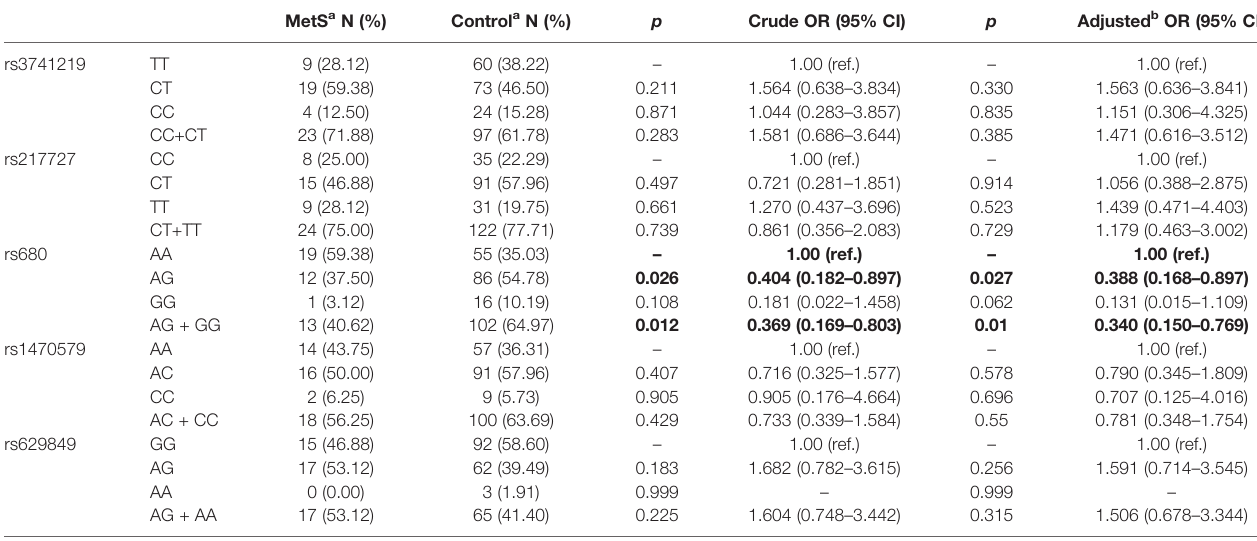
Bold indicated signi fi cant statistical difference. a The observed genotype frequencies of SNPs among the MetS and Control were all in agreement with the Hardy – Weinberg equilibrium ( p > 0.05 for all). b Adjusted for age, smoking and drinking. MetS, Metabolic Syndrome.